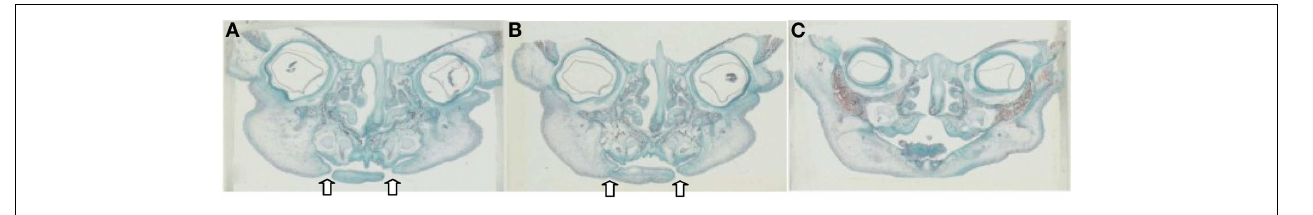
correspond to progression at the A–P direction). Note the two bilateral discontinuations at the lower lip area, one more extensive than the other, both lined with